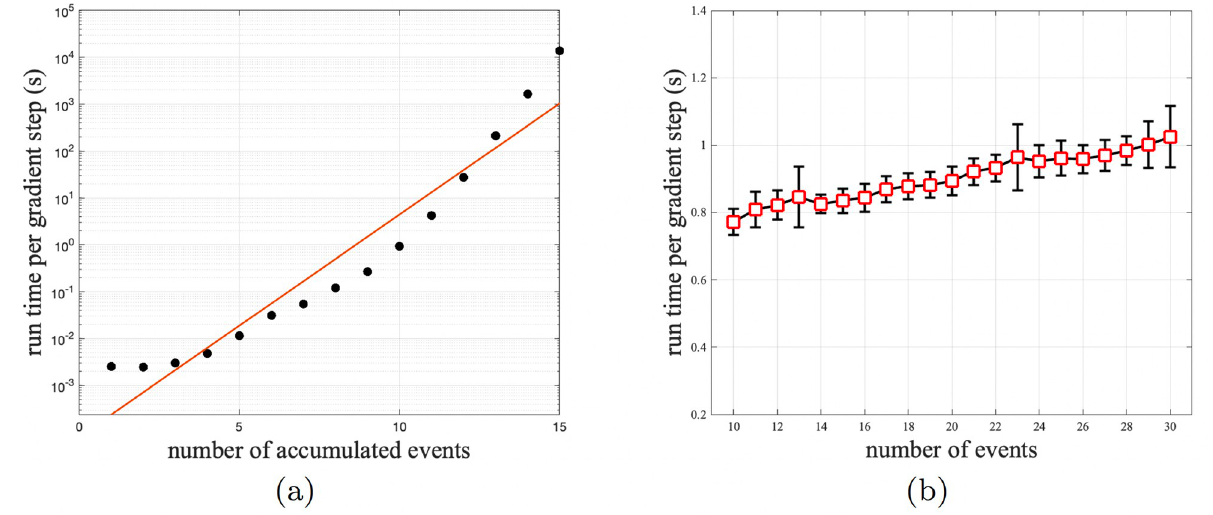
Fig 4. The time cost of one gradient step is plot against different (a) number of accumulated events k and (b) number of events n . categories: missense, nonsense, in-frame indels, frameshift indels, and splice site. As these